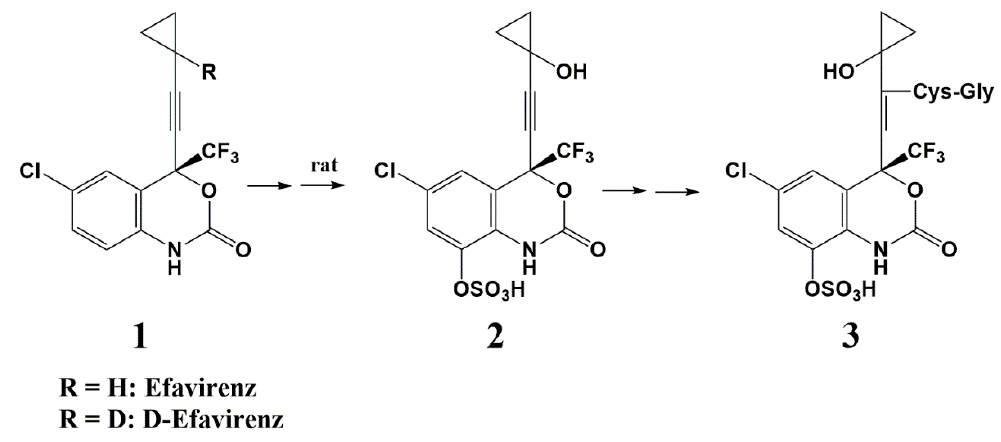
Figure 2. Efavirenz metabolism in rats that leads to the nephrotoxic glutathione conjugate (3).